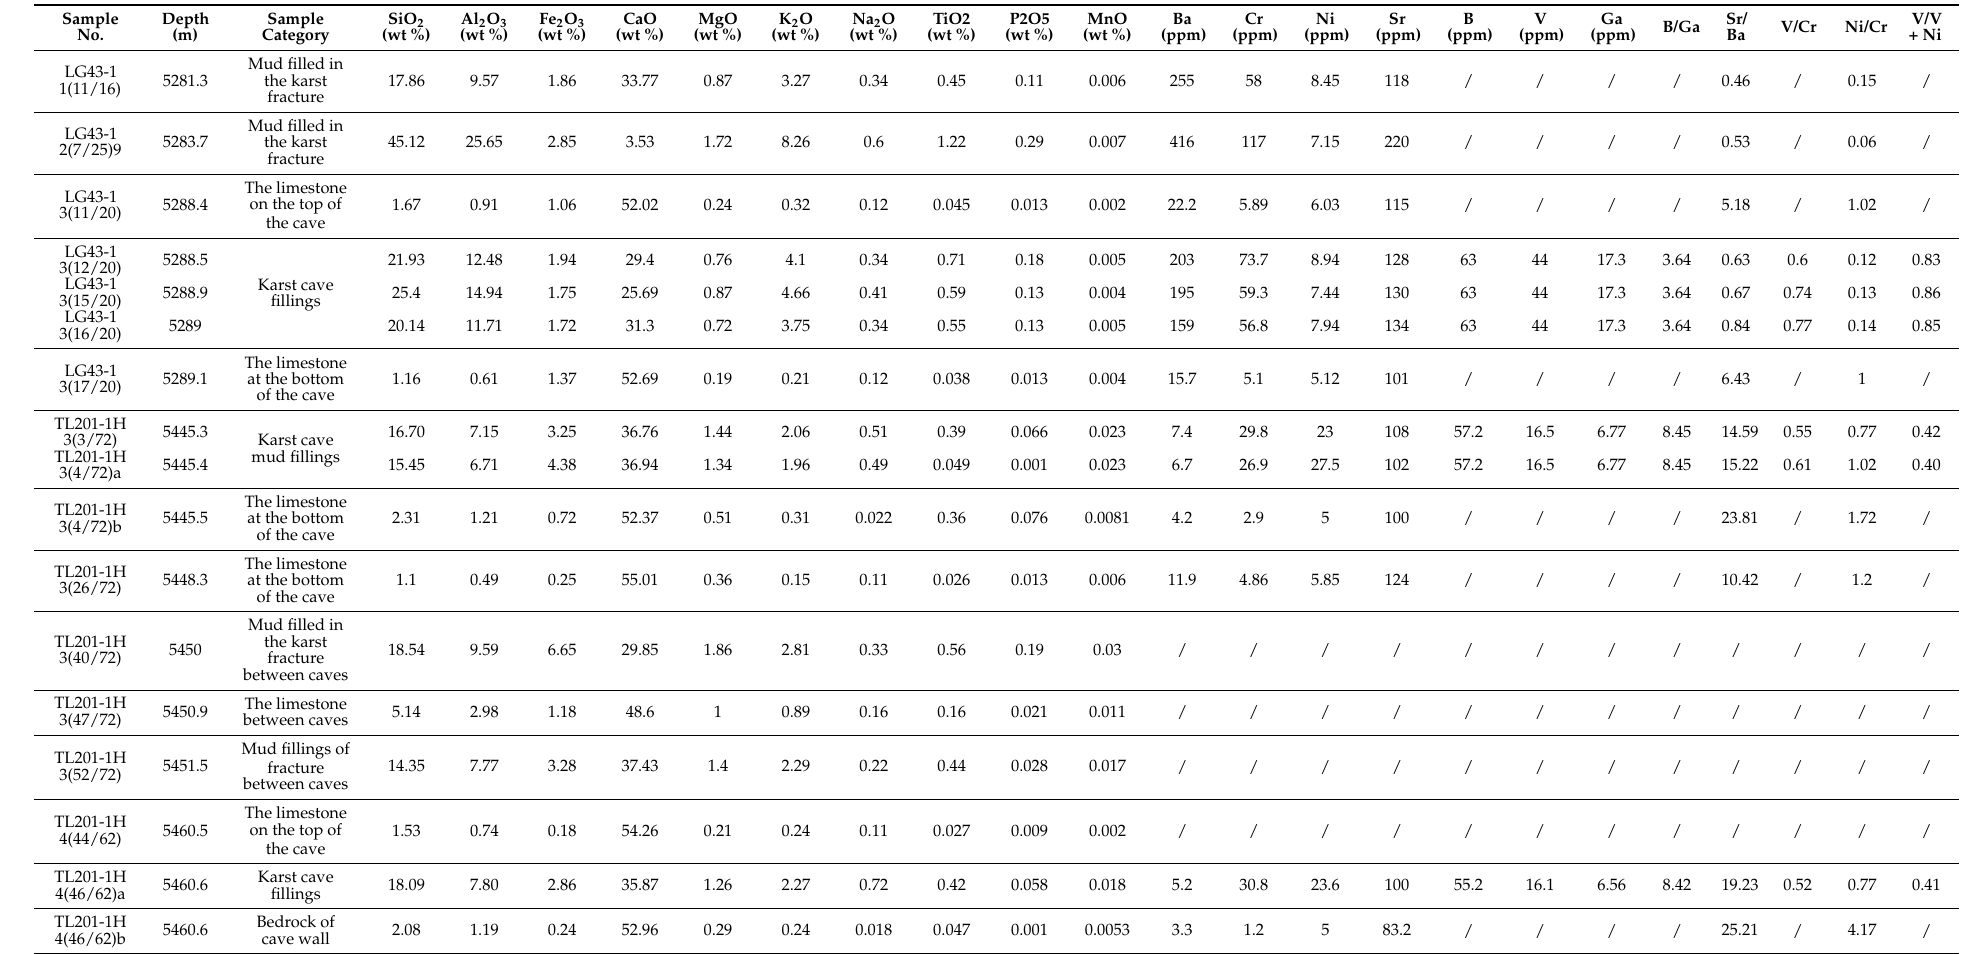
Table 2. Test results of main and trace elements of fracture-cave fillings and nearby